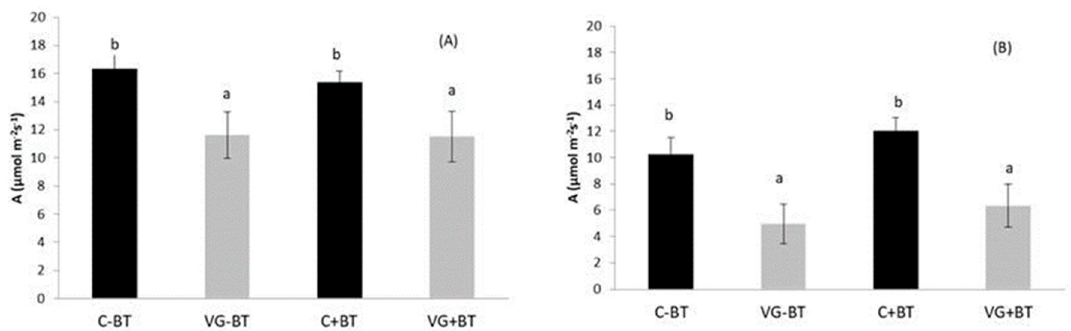
Figure 2. Assimilation rate (A) measured at harvest, in the years 2013 ( A ) and 2014 ( B ) on fully expanded Falanghina leaves sprayed with anti-transpirant Vapor Gard ® (VG) at 2% or left unsprayed (C) with or without bunch thinning (BT). Data are averages of 10 replicates ± SE. Same letter indicates not significant differences at Duncan post hoc test ( p < 0.05).